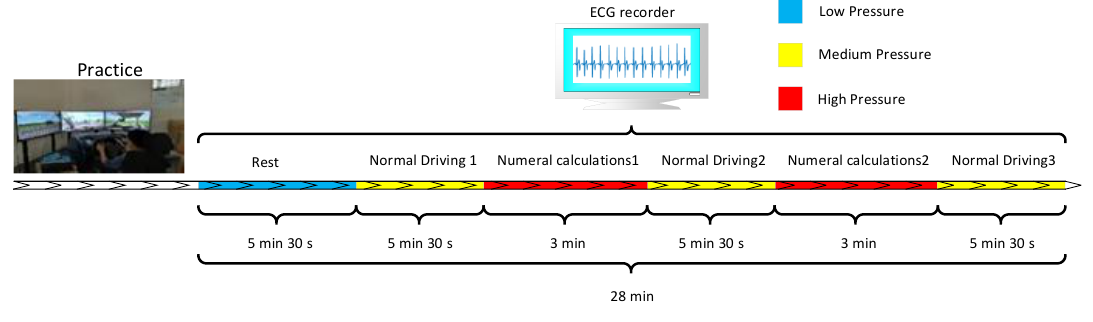
Figure 2. Driving simulation experiment.